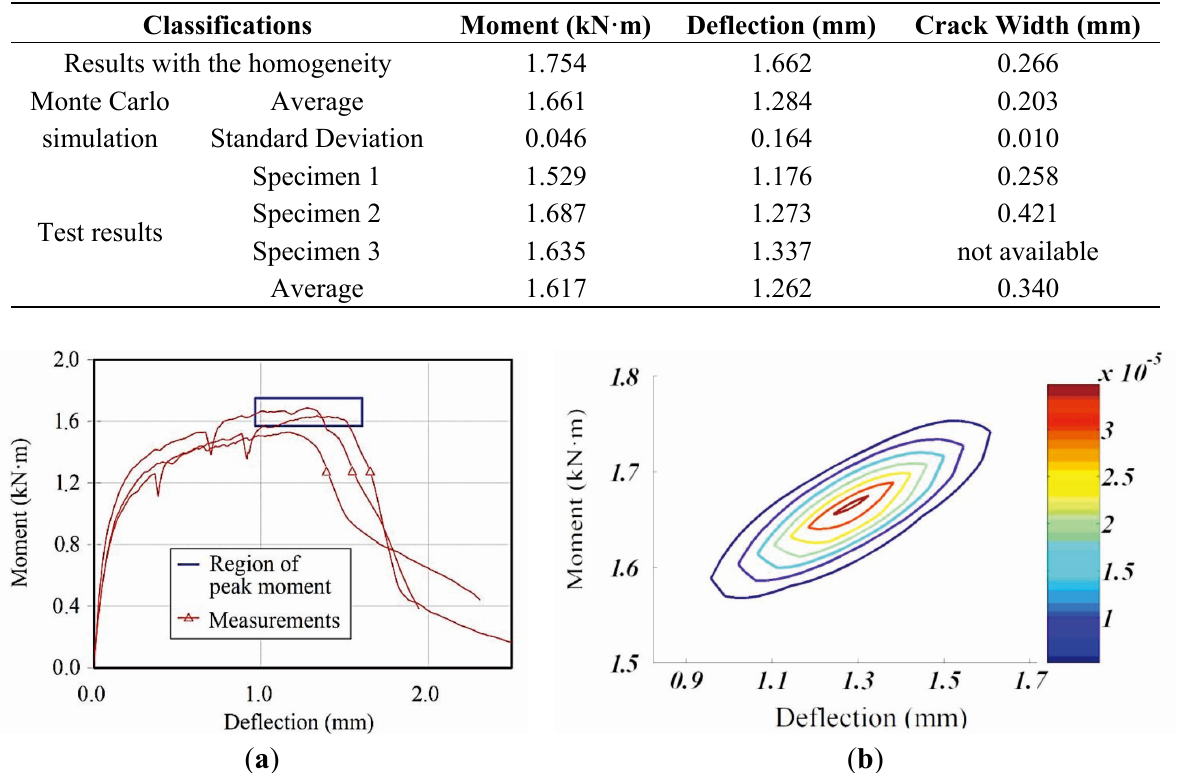
Table 2. Analysis and test results at a maximum moment.